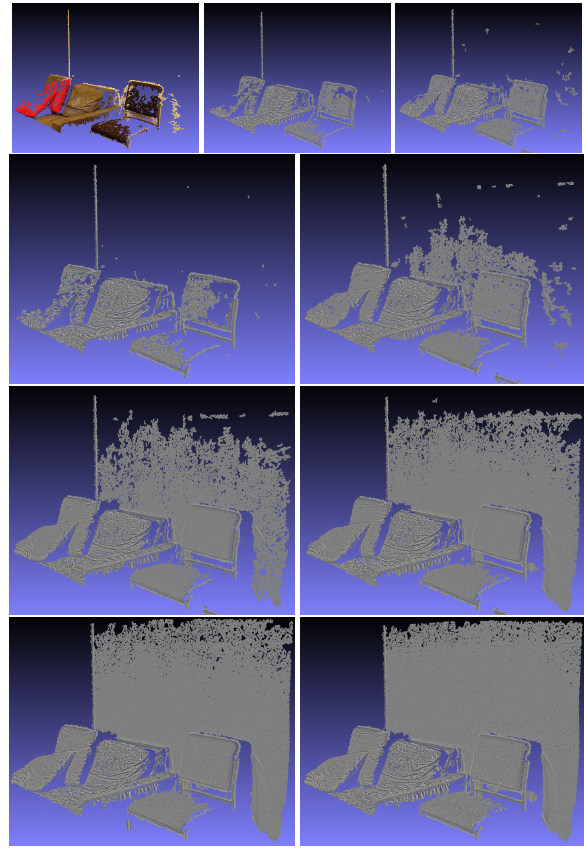
Figure 8. Wall dataset. Top row: SE, SEW, SEBW; Second to fourth row: ME- 1 , - 2 , - 4 , - 8 , - 16 , - 30 images, respectively.